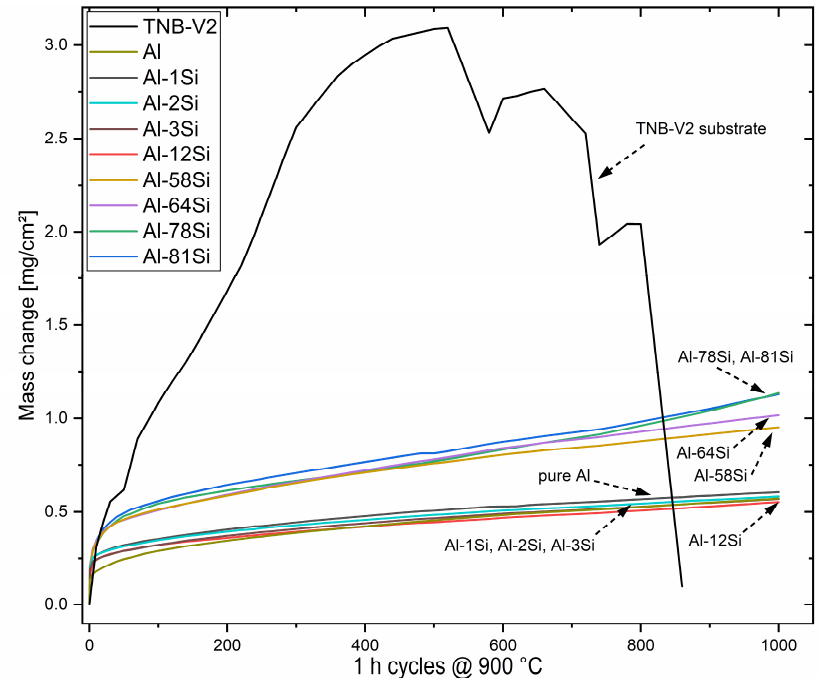
Figure 4. Mass change curves versus the number of 1 h cycles during oxidation tests at 900 °C in lab air for up to 1000 cycles of the bare and coated TNB-V2 alloy. Table 3. Based on the cyclic oxidation tests, the estimated parabolic growth rate constants (K p ) of the different Al-Si coatings in mg²/cm 4 h, as well as the mass change by the initial oxide formation ( ∆ m i ) in mg/cm 2 (calculated with the data from 100 to 1000 cycles) and the total mass gain ( ∆ m 1000C (mg/cm 2 )), are determined after cyclic oxidation at 900 ◦ C up to 1000 cycles on TNB-V2. Coating